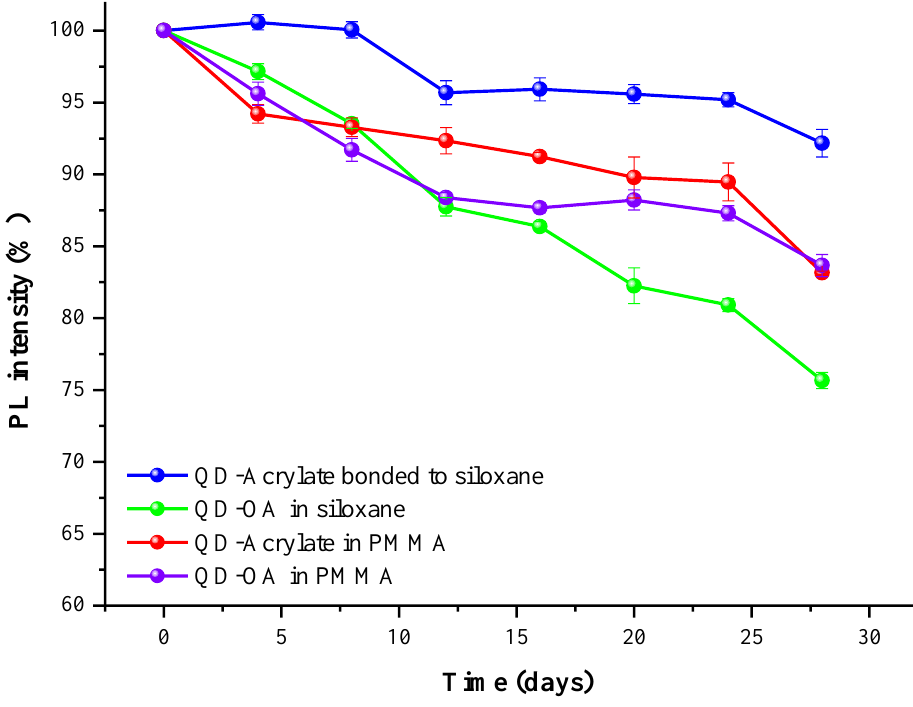
Figure 6. Stability test results for the film formed by hydrosilylation and for other QD samples at conditions of 85 °C and 85% relative humidity (RH), as determined by photoluminescence spectroscopy.